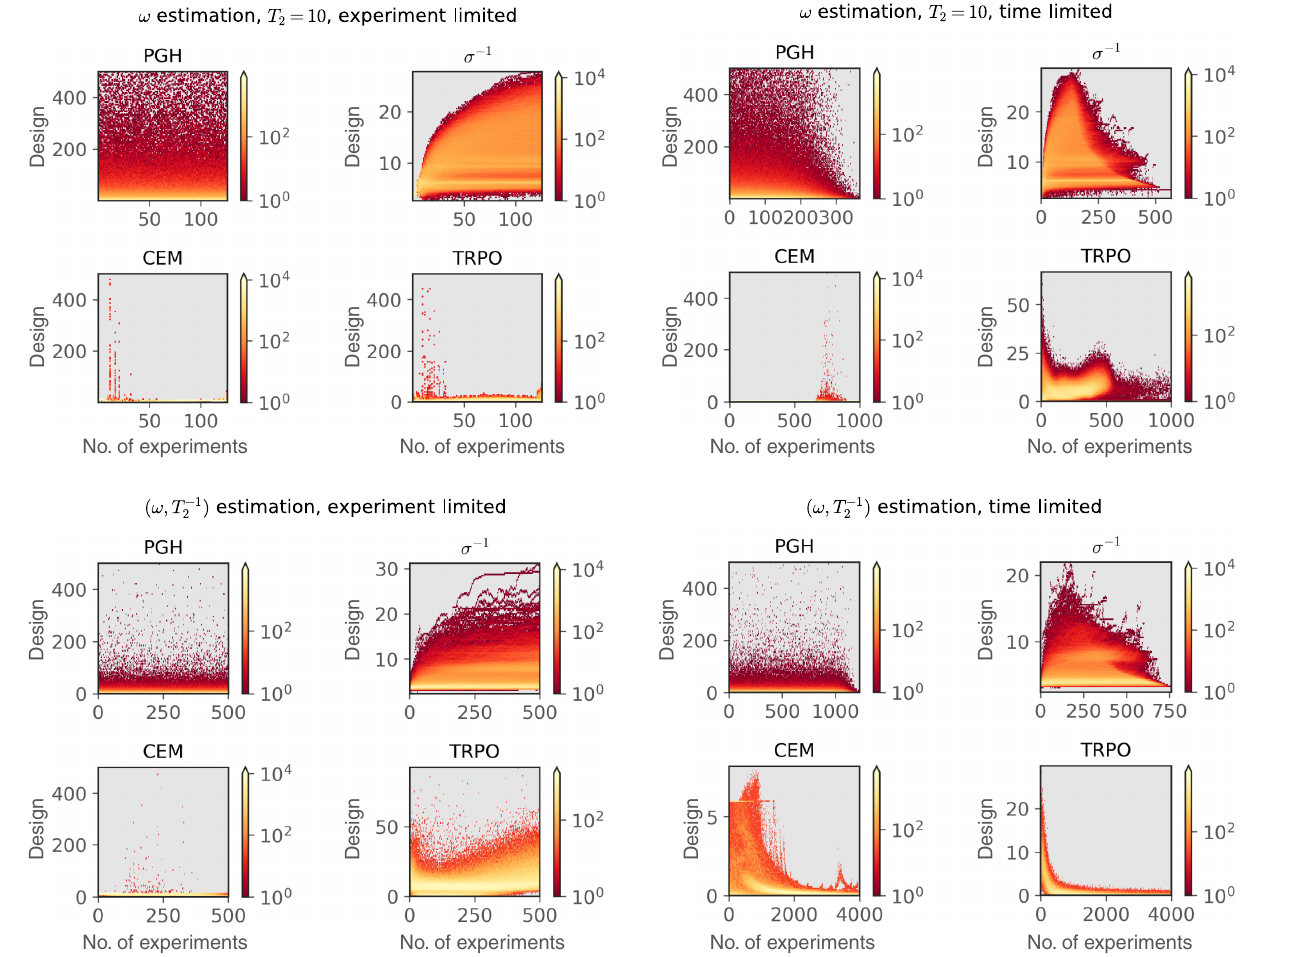
FIG. 7. As for Fig. 6, the only difference being that this figure shows data for different estimation problems as specified in the titles of the